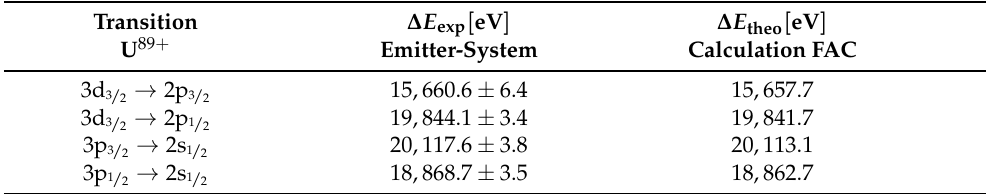
Table 1. This table lists the measured and Doppler-corrected L-shell-transitions used for the es- timation of the 2s Lamb shift of uranium. The given errors represent the approximated statis- tical uncertainty of the lines (see the text for details). An additional systematic uncertainty of − 4 has to be taken into account. For comparison, the corresponding energy value ∆ E syst / E ≈ 8 × 10 calculated by FAC is given as